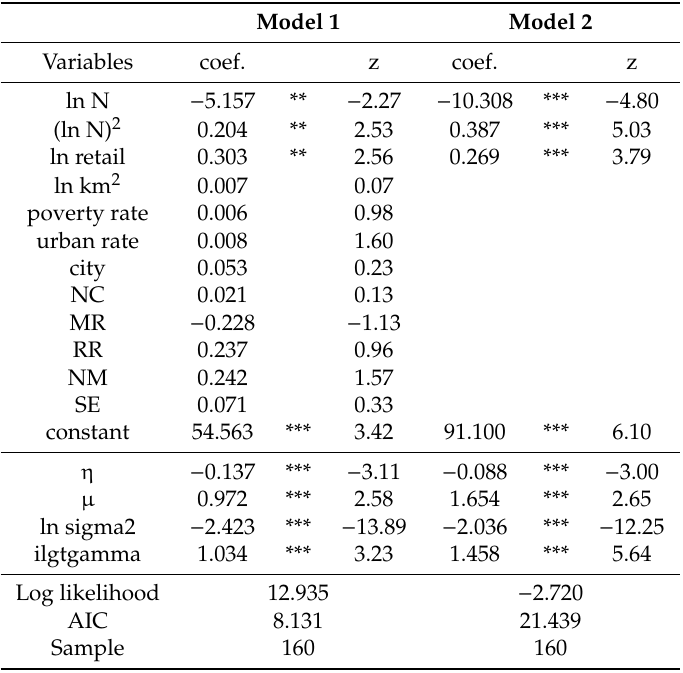
Figure 1. Test of hypotheses for stochastic frontier cost function model. Table 2. Estimation results.